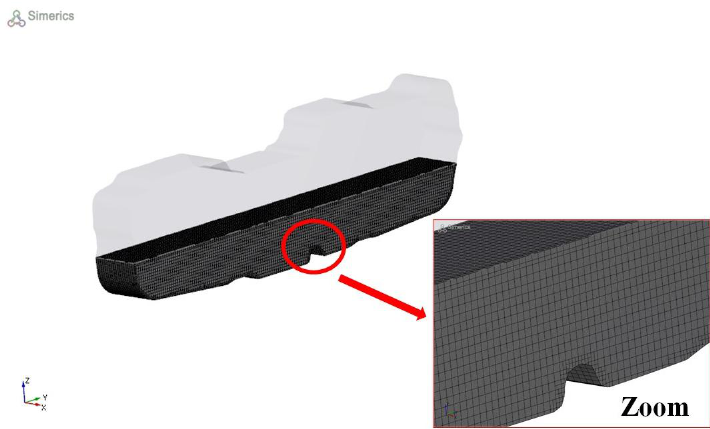
Figure 8. Mesh of the fluid volume.